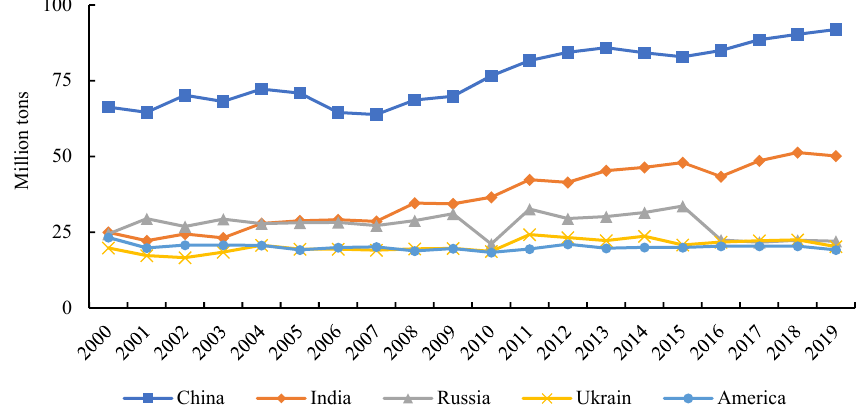
Figure 2. Potato production variation of the top five potato producing countries during the period 2000–2019. Date from reference [12]. Copyright 2021 FAO.